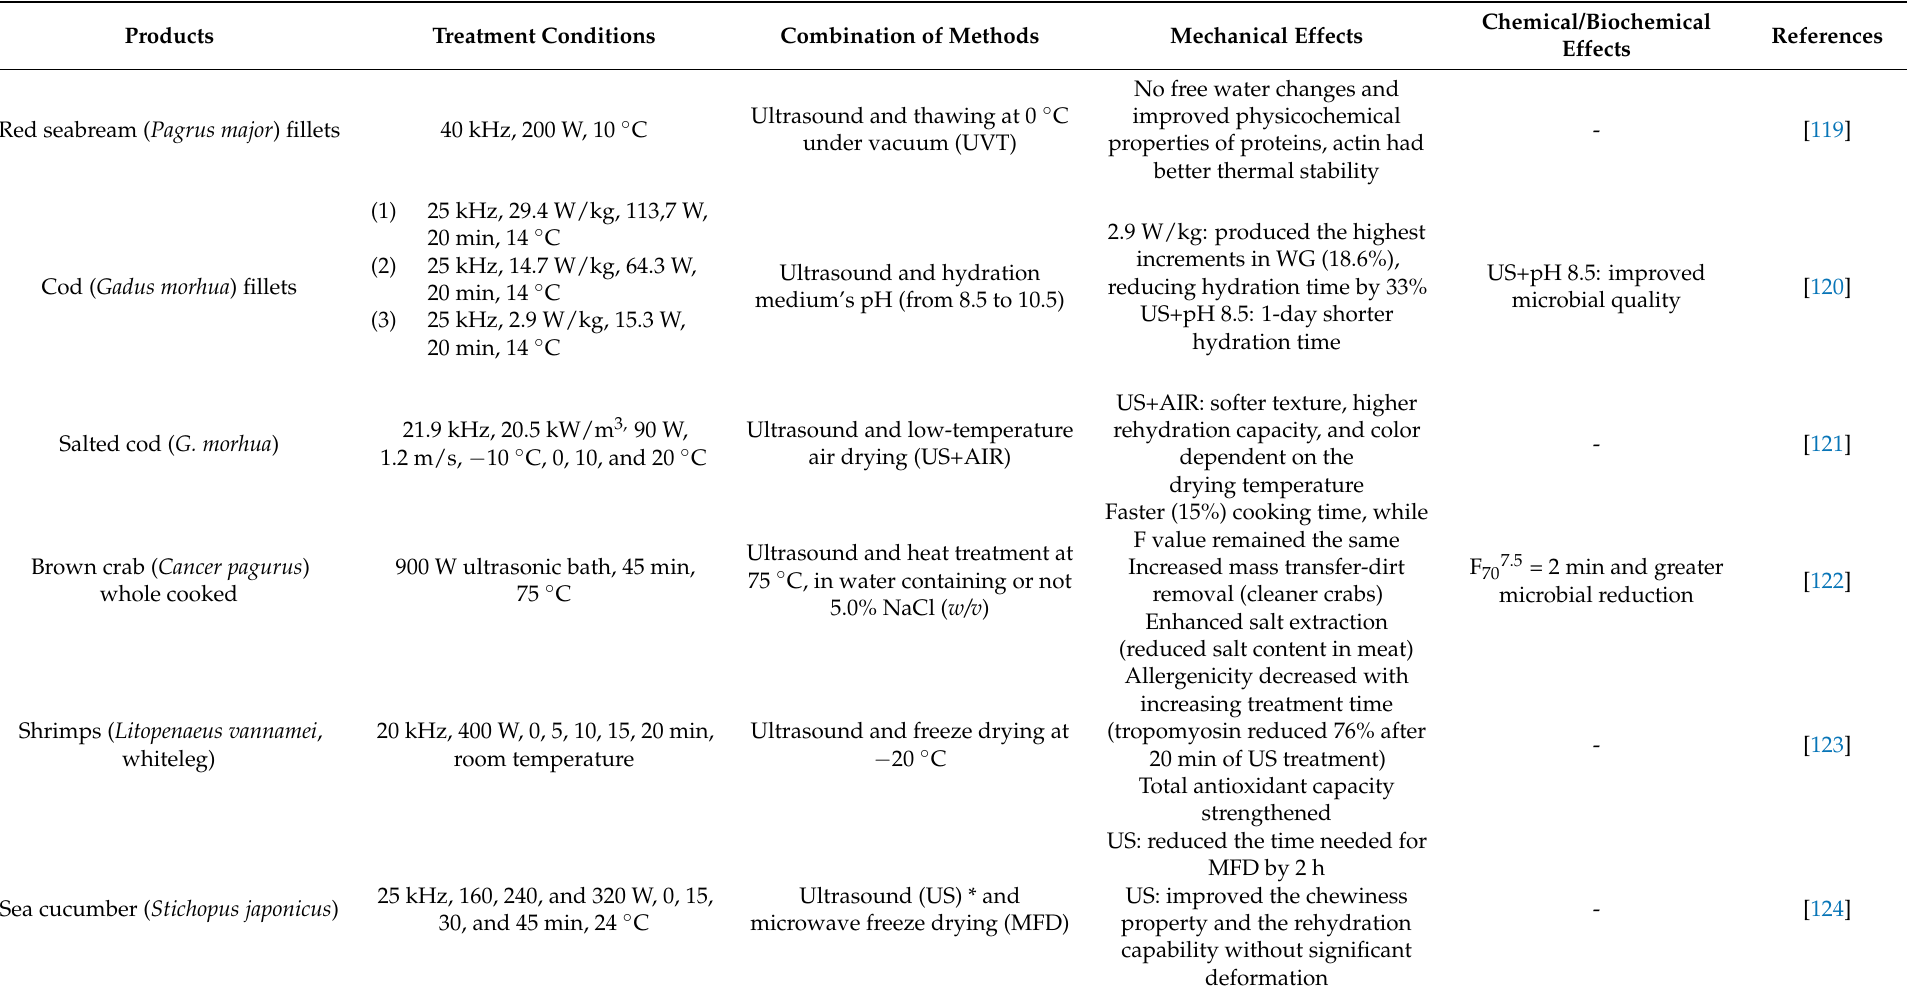
Table 2. Studies on the application of HP treatment on fish and seafood